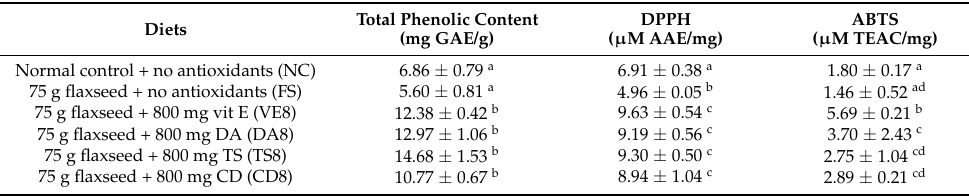
Table 2. Phenolic contents, DPPH, and ABTS radicals scavenging capacities of test